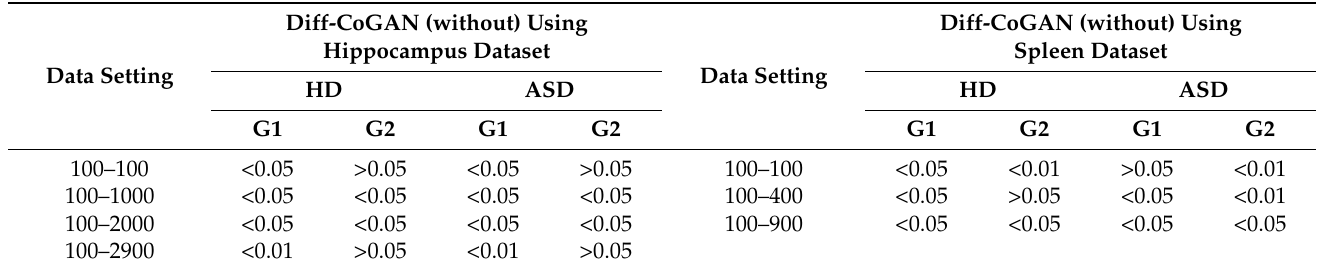
Table 13. Paired t -test between Diff-CoGAN with intersection and Diff-CoGAN without intersection operation. The t -test was performed on both Hippocampus and Spleen datasets.